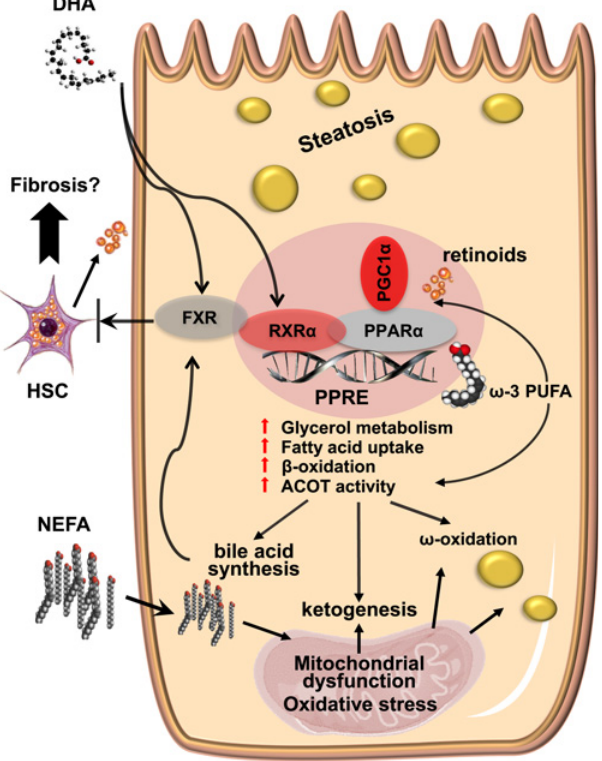
Fig 7. Spaceflight induces activation of PPAR α pathways maintained by a feedback loop involving hepatic thioesterase activity and mediated by DHA. Elements of the space environment such as microgravity, oxidative stress and radiation may lead to activation of the PPAR α -RXR α heterodimer by ω -3 fatty acids (including DHA), PGC-1 α and retinoids from activated HSCs, increasing thioesterase activity. Hepatic steatosis, as well as synthesis of bile acids, ketone bodies and dicarboxylic acids, results from activation of downstream pathways. Fibrosis may also ensue from transformation of the activated HSCs. DHA and bile acids are ligands for FXR, which may be activated in a compensatory manner and help protect from HSC-induced remodeling of the ECM. PPRE, peroxisome proliferator response